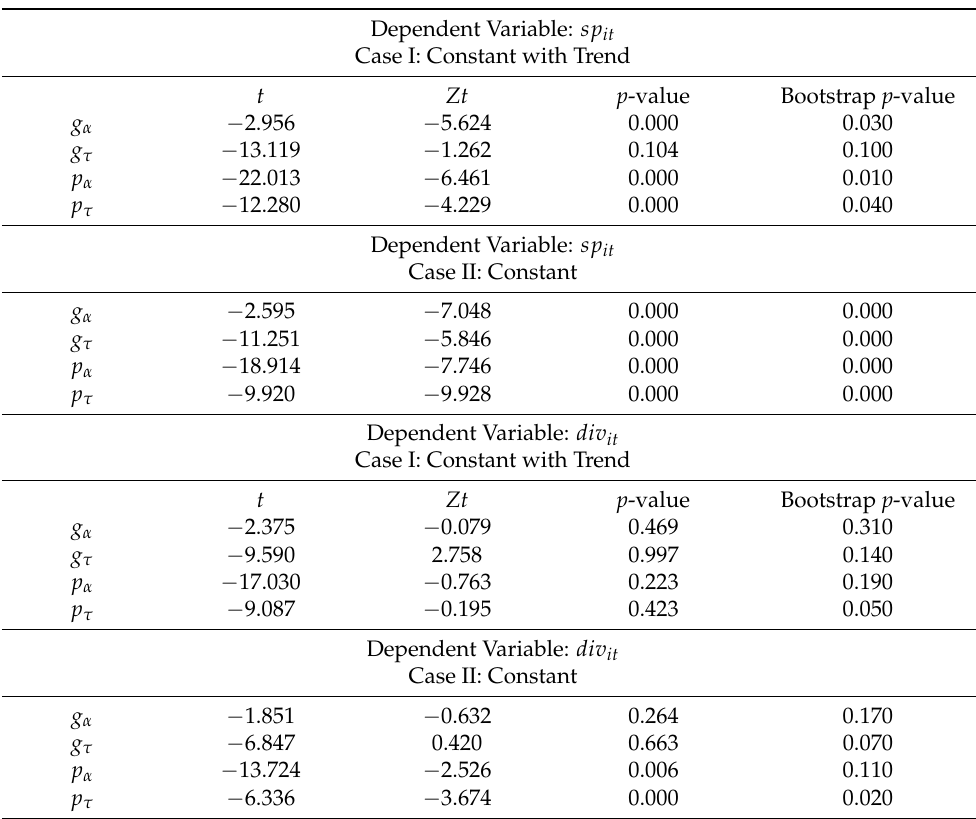
Table 6. Westerlund (2007) ECM-based cointegration